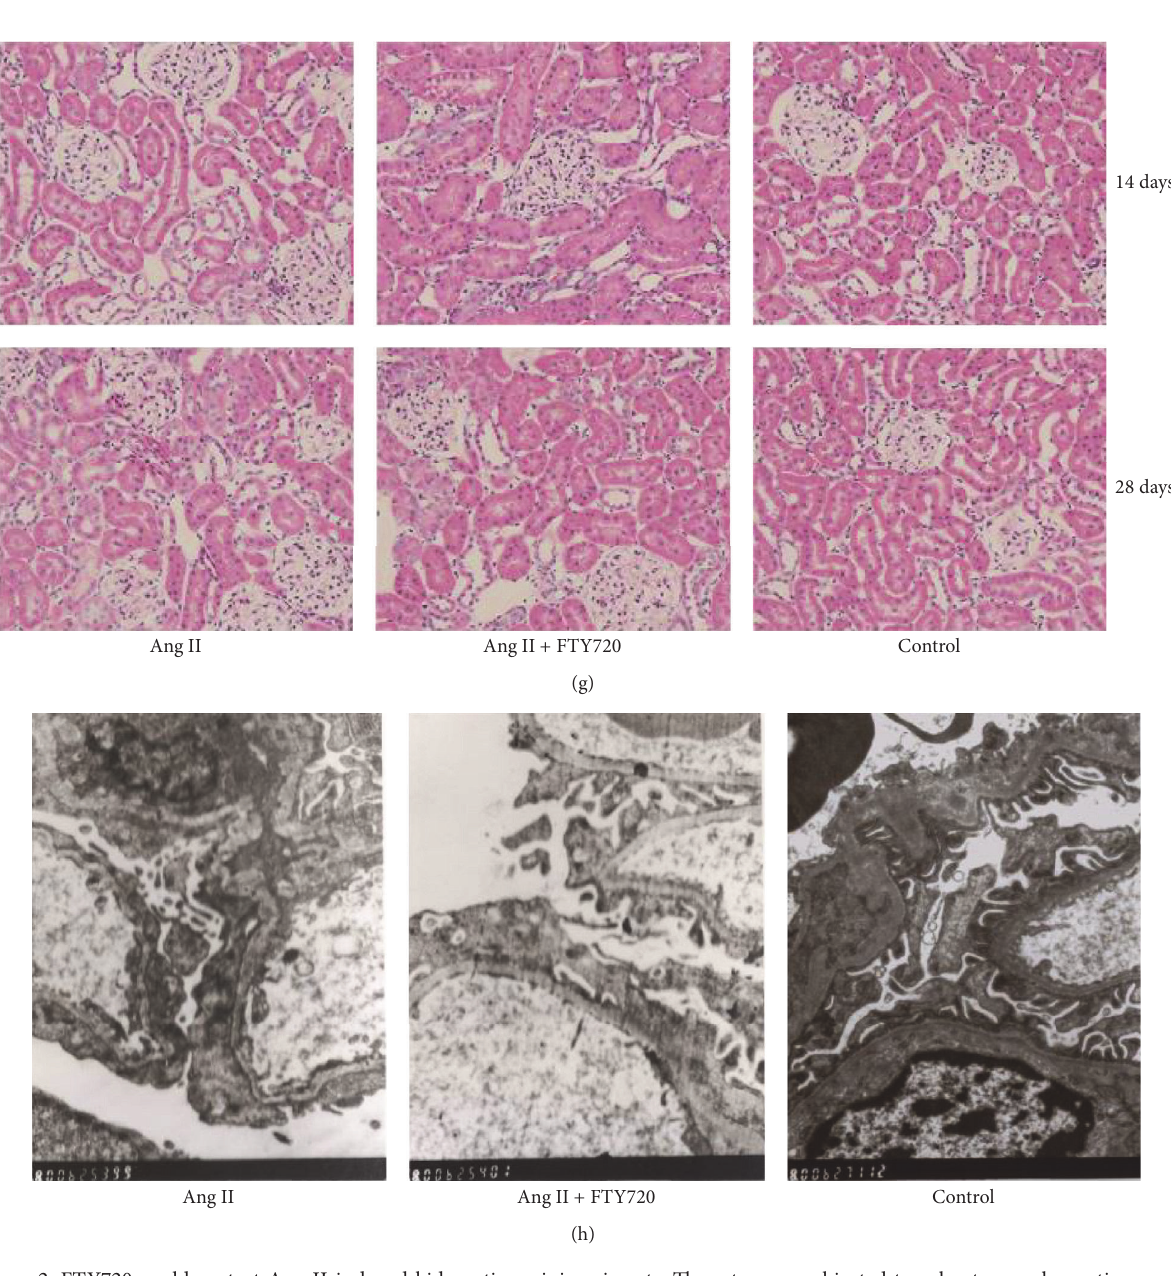
Figure 2: FTY720 could protect Ang II-induced kidney tissue injury in rats. The rats were subjected to subcutaneously continuous Ang II-infusion (400 ng/kg ⋅ min) for 14 or 28 days and were sacrificed. Rats given FTY720 (0.5 g/kg ⋅ d gavage) for 14 or 28 days also received Ang II-infusion. After the mice were sacrificed, the kidneys were fixed in paraformaldehyde for HE staining. The other parts of renal cortex were fixed in glutaraldehyde and podocytes were analyzed using transmission electron microscope. Kidney homogenate was used for RIA analysis. The plasma and serum were separated for biochemical analysis. Data represented is means ± SD of six independent experiments performed in triplicate. ( 𝑛 = 6 ) ∗ 𝑃 < 0.05 , versus normal saline infusion control rats; # 𝑃 < 0.05 , versus Ang II-infusion rats. (a) Serum creatinine levels in Ang II and FTY720-treated rats. (b) Serum urea nitrogen levels in Ang II and FTY720-treated rats. (c) Serum albumin levels in rats treated with Ang II and FTY720 for 14 and 28 days. (d) Concentration of Ang II in plasma from rats treated with Ang II and FTY720 for 14 and 28 days. (e) Concentration of Ang II in renal tissue homogenate from rats treated with Ang II and FTY720 for 14 and 28 days. (f) Twenty-four- hour urinary protein excretion levels in rats treated with Ang II and FTY720 for 14 and 28 days. (g) Light microscopy evaluation of rat kidney pathological changes with hematoxylin and eosin (H&E) staining (magnification, × 200). (h) Transmission electron microscopy evaluation of micrographs of podocyte ultrastructure in rats (magnification, ×